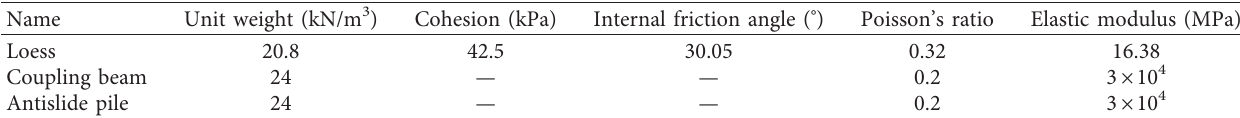
Table 2: Material